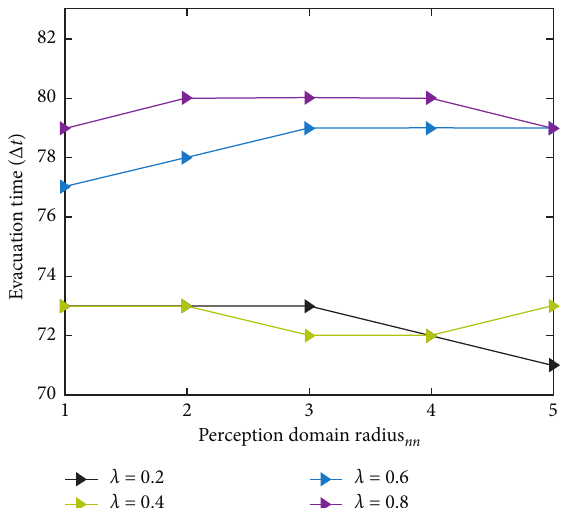
Figure 15: Total evacuation time with different perception domain radius in scenario 2 ( β � 0 . 5, c � 0 . 5).